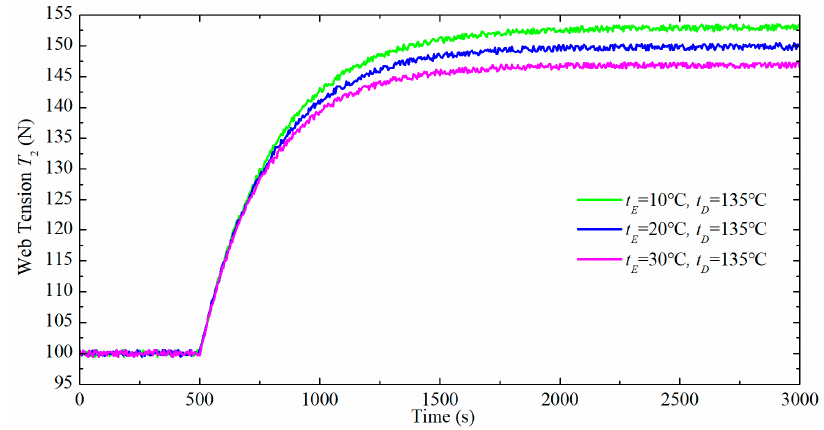
( ) T t as ( ) v t has step changes at different room 2 2